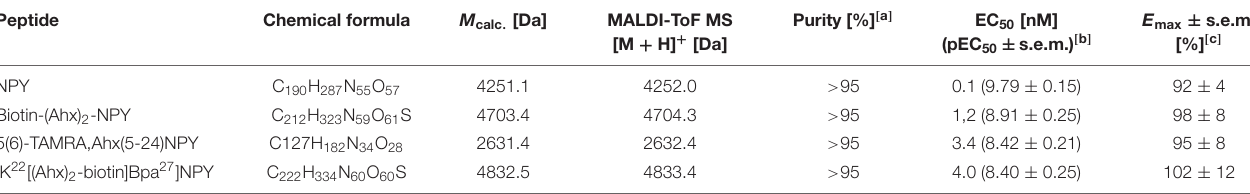
TABLE 4 | Analytical characterization of NPY analogs for ligand affinity chromatography, crosslinking experiments and binding assays. Peptide Chemical formula M calc . [Da]